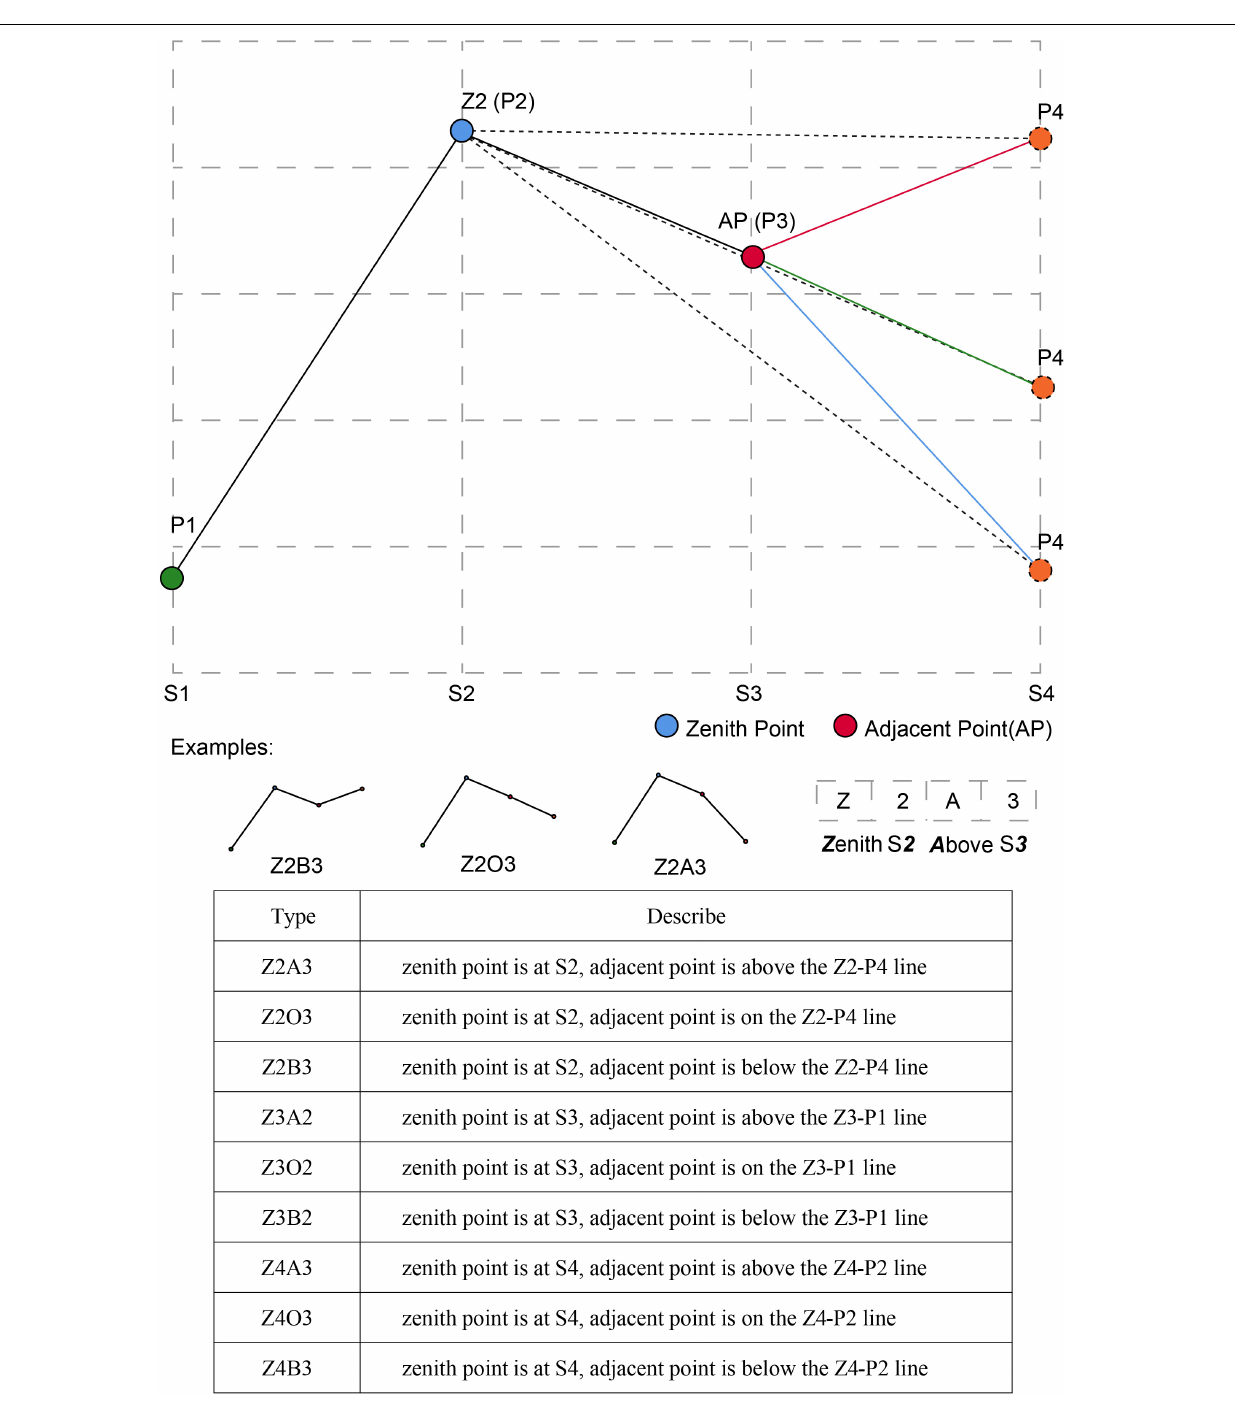
increase the number of pixels depends on the spatial resolution of the DSM. Finally, space Kriging interpolation was performed on the points, and the maximum value was taken as a representative value of PH at the plot scale. Using this method, a time series of PH dataset was obtained for later dynamic analysis ( Figure 1D